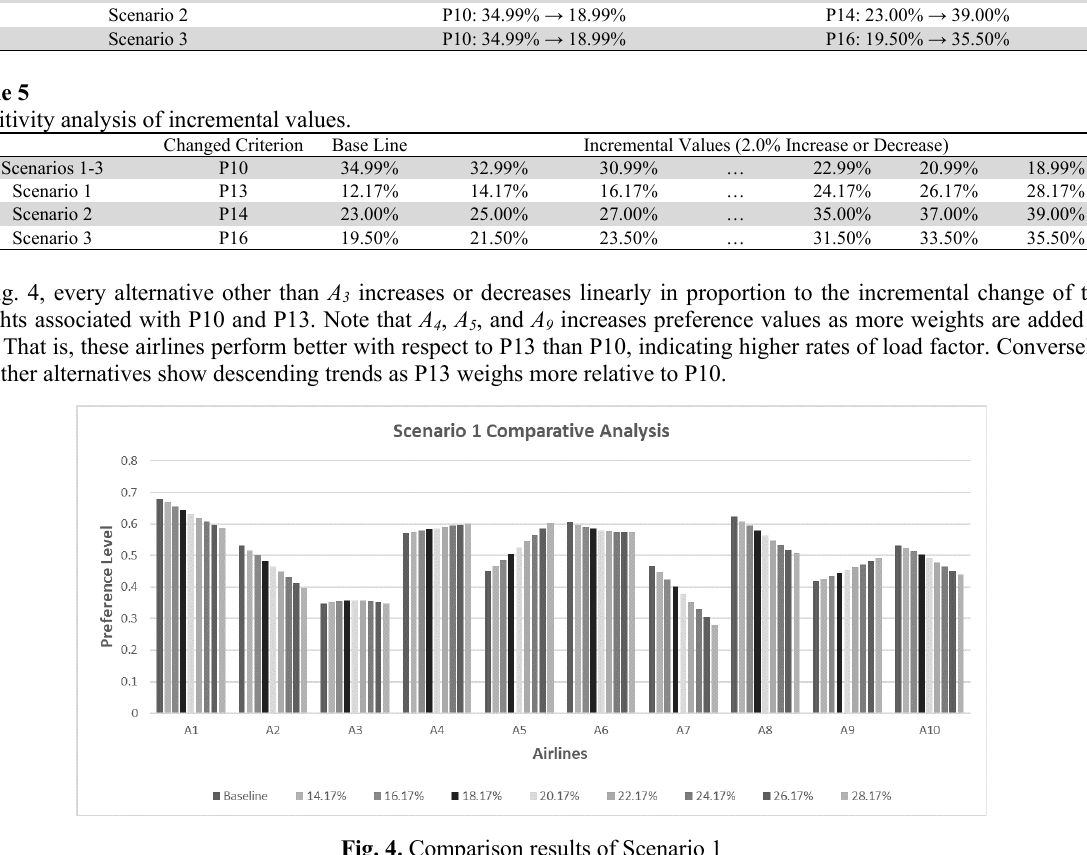
Fig. 4. Comparison results of Scenario 1